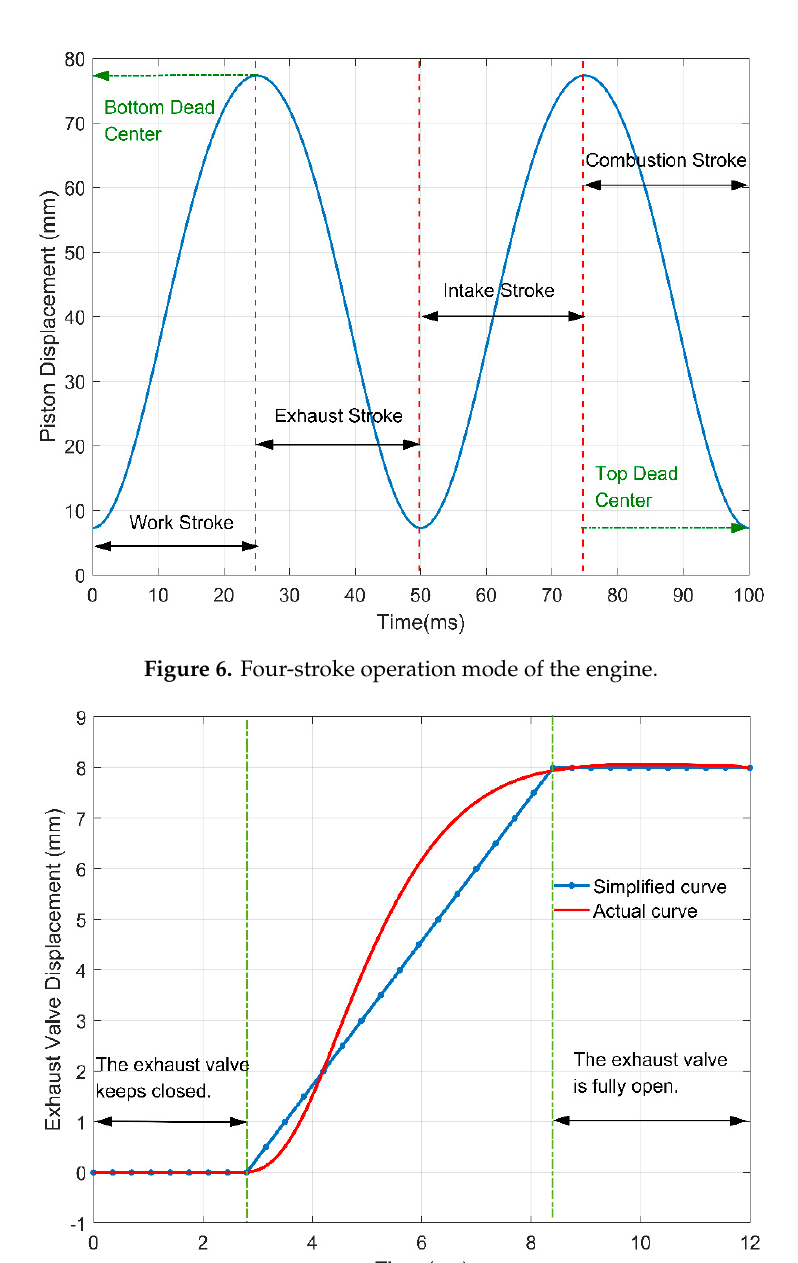
Figure 7. Displacement curve of the exhaust valve.